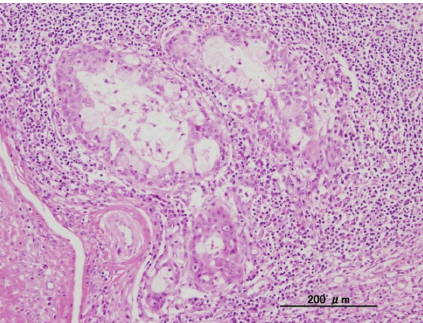
Figure 6: Pathological findings for low-grade malignancy. Ducts formed from goblet cells are clearly